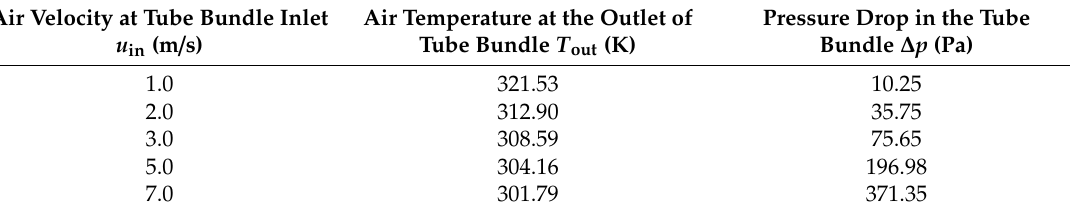
Table 4. Output data for the perforation hole Ø2 mm.